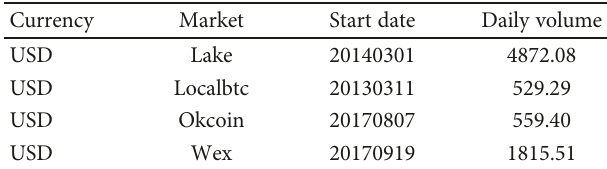
Table 2: Basic information for each market of top 8 exchange